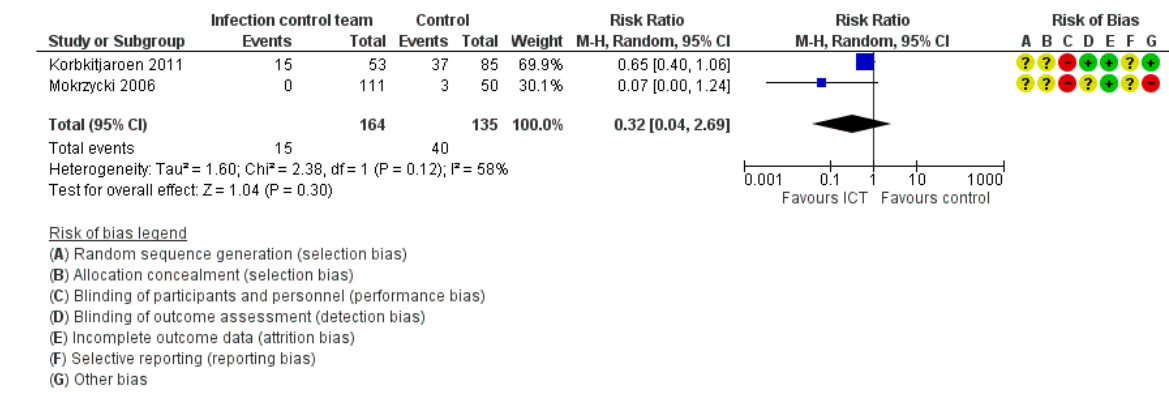
Figure 5. Meta-analysis for the death due to HCAIs [28,31].